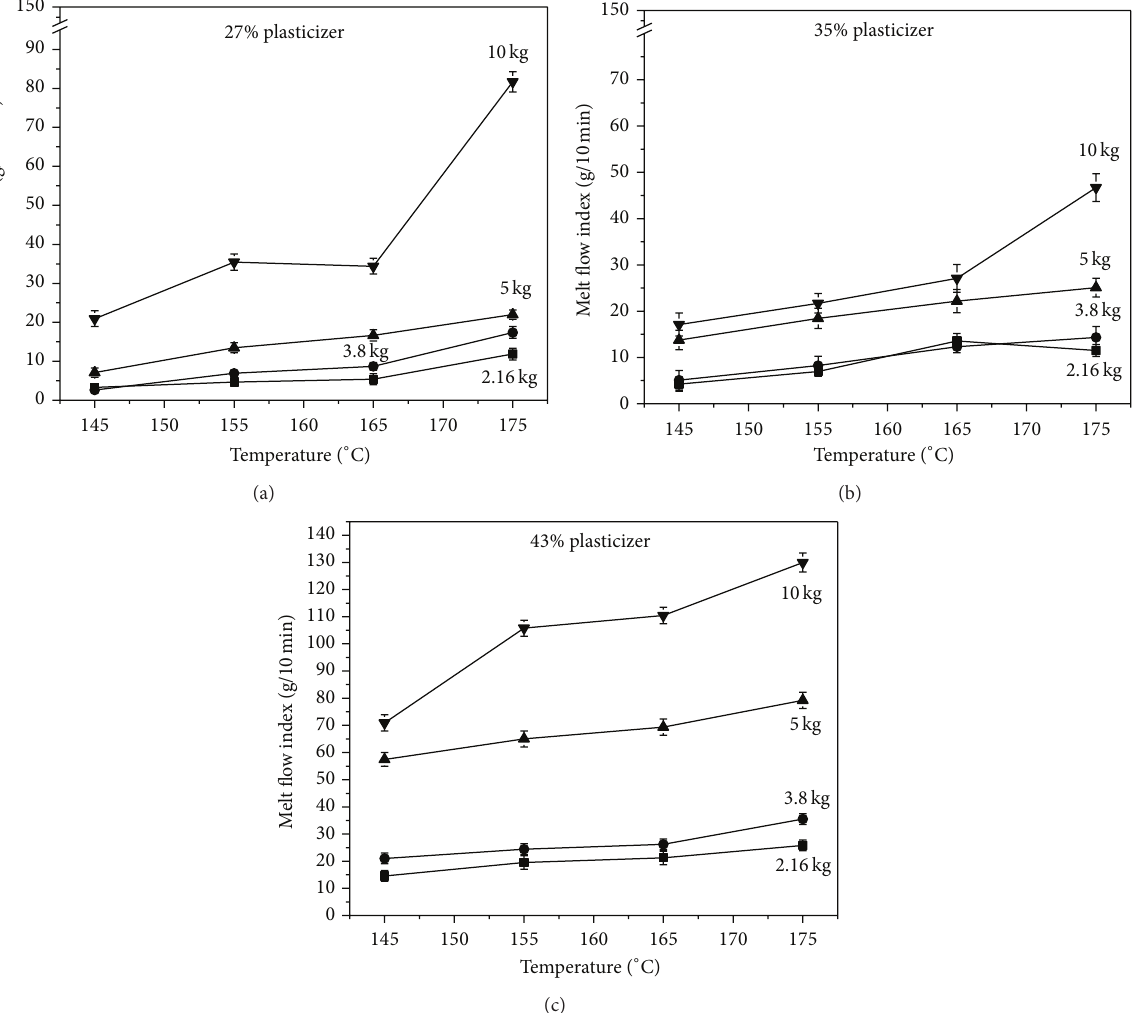
Figure 2: The dependence of the MFI on the extrusion conditions and the plasticizing level ((a) 27%; (b) 35%; (c)